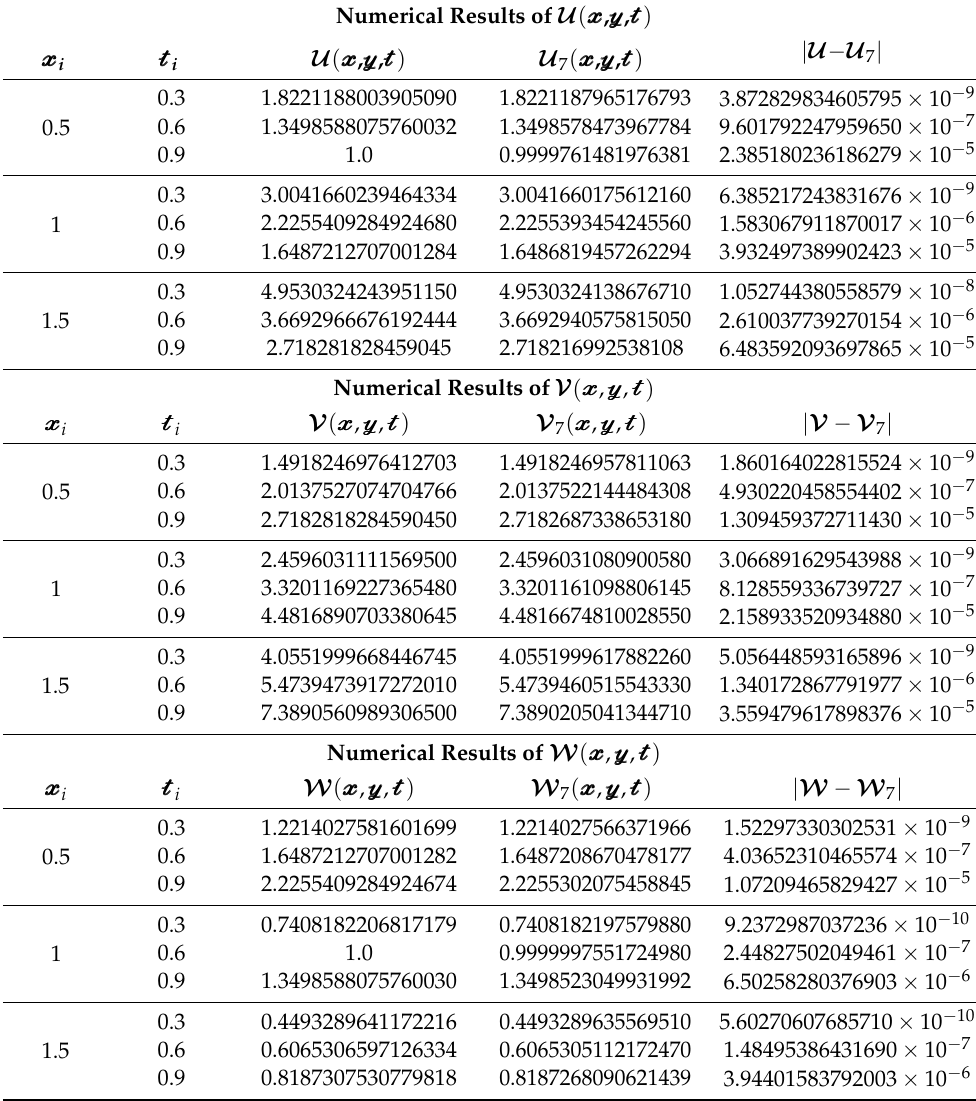
Table 3. Numerical results for Example 3 at different values of 𝓍 , 𝓎 = 0.4, 𝒶 = 1, and n =